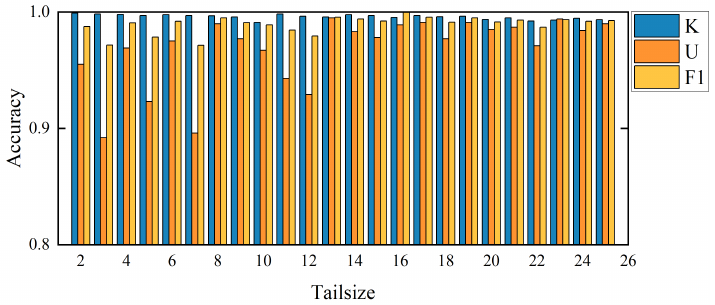
Figure 12. The relationship between the tailsize value and precision of the JNU dataset.